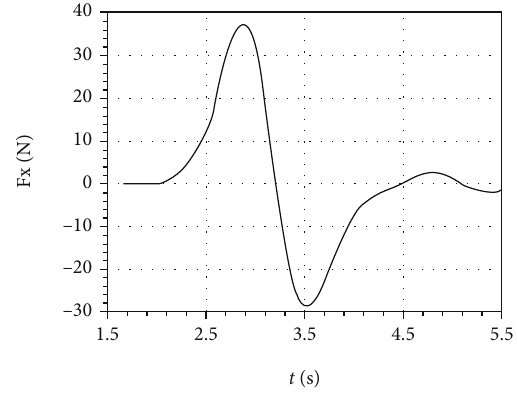
Figure 4: Time evolution of the in-line force on a single cylinder.